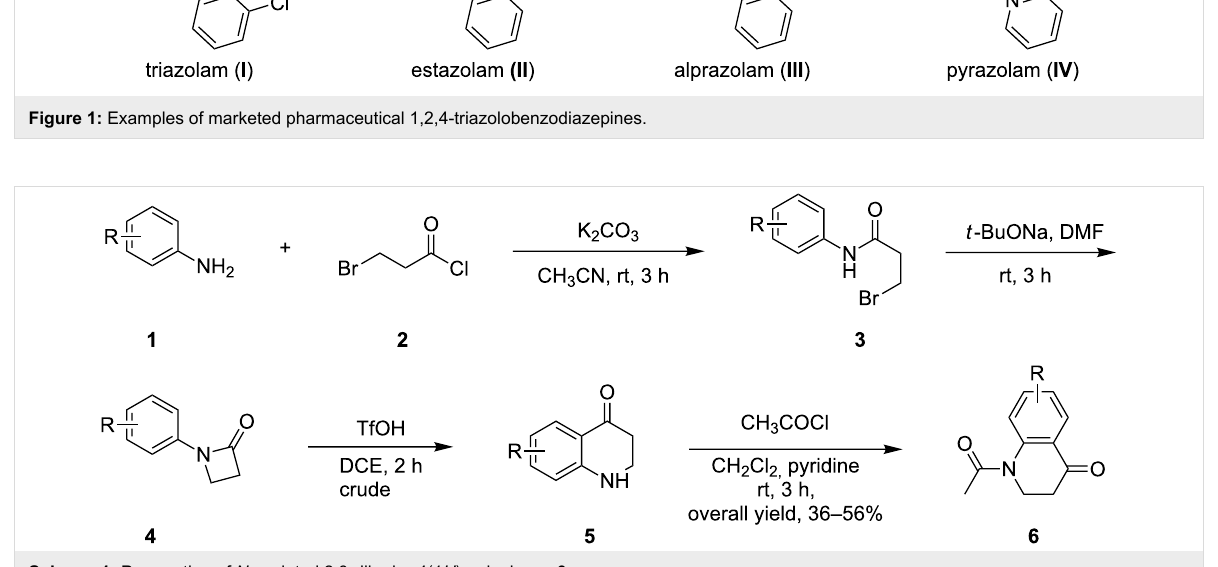
Scheme 1: Preparation of N -acylated 2,3-dihydro-4(1 H )-quinolones 6